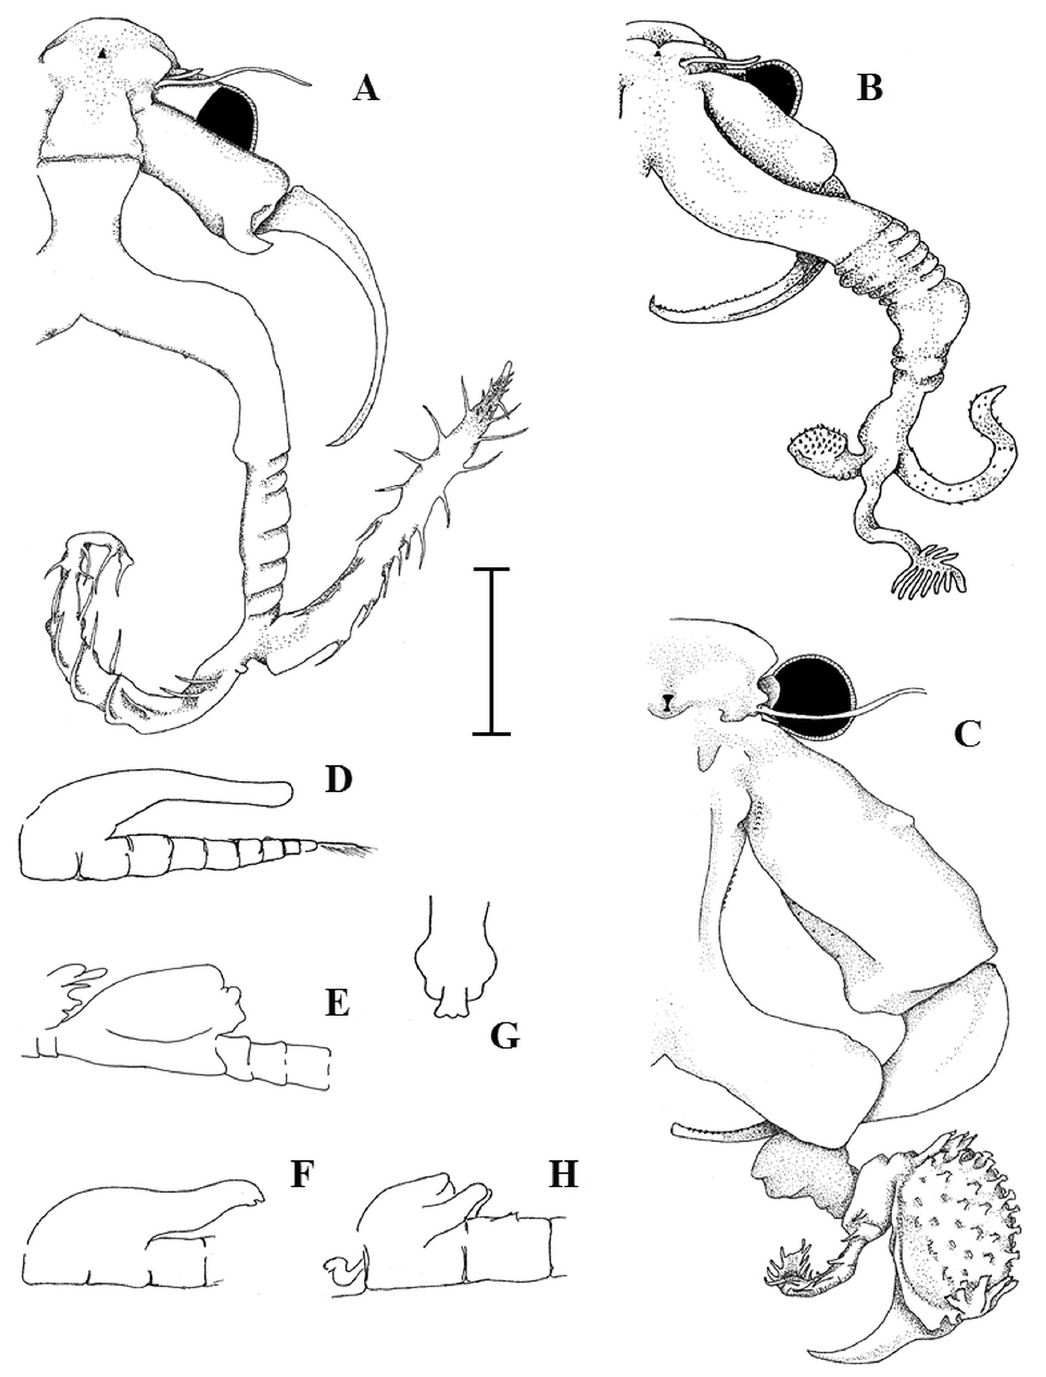
Fig. 1. Dendrocephalus spec. A. Dendrocephalus acacioidea , male head, left side, anterior view. B. Dendrocephalus alachua , male head, left side, anterior view. C. Dendrocephalus lithacus , male head, left side, anterior view. D. Dendrocephalus acacioidea , brood pouch, right, lateral view. E. Dendrocephalus alachua , brood pouch, right, lateral view. F. Dendrocephalus lithacus , brood pouch, right, lateral view. G. Dendrocephalus lithacus , male, labrum, ventral view. H. Dendrocephalus lithacus , gonopods, right, lateral view. Scale bar: A–C = 1 mm; D–F, H = 4 mm; G = 0.25